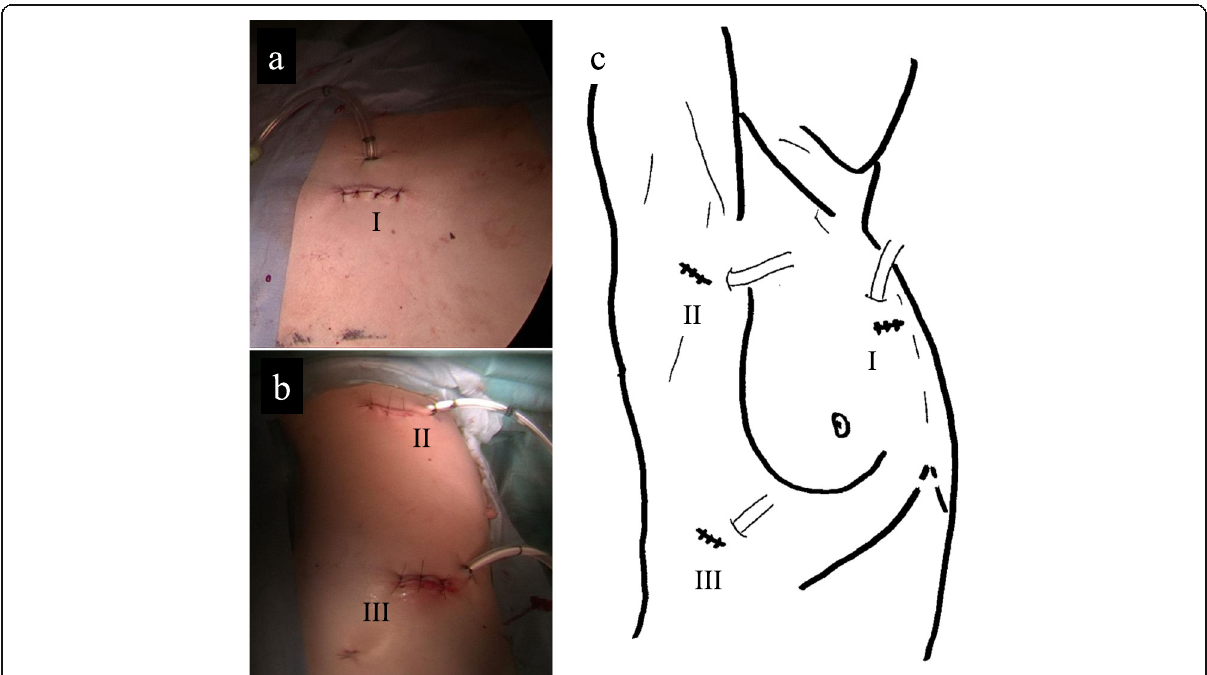
Fig. 5 The pictures of three skin incisions and drainage tube ( a , b ) and their schema ( c ). Cavities I to III were debrided from the skin incision sites I to III,